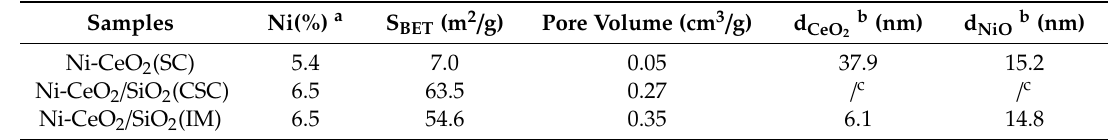
Table 1. Physical properties of the fresh catalysts